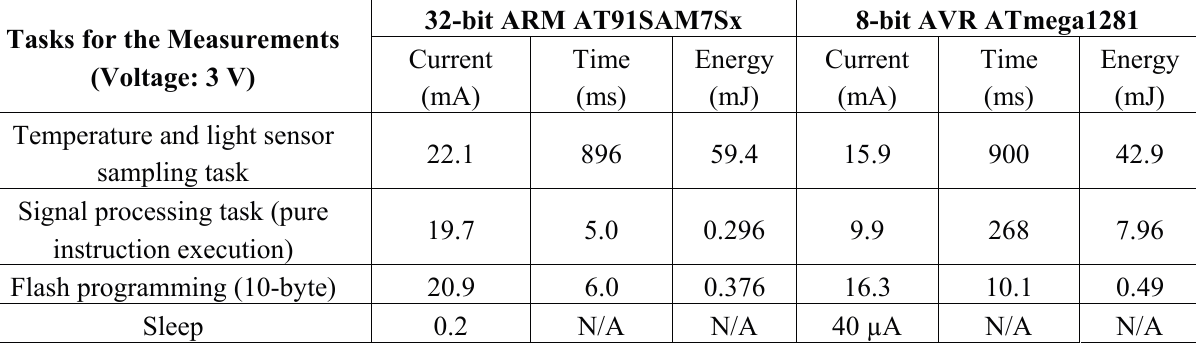
Table 10. Energy consumed by executing different tasks on different